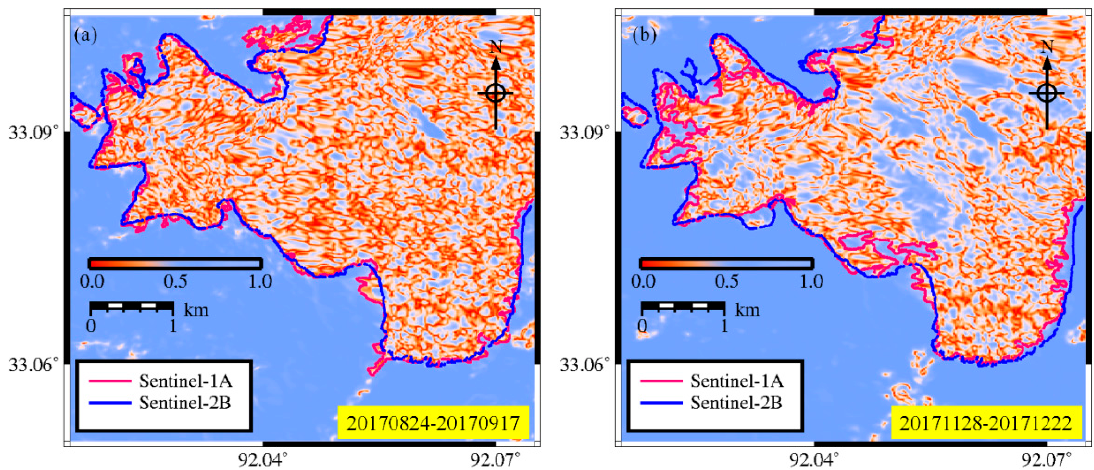
Figure 12. ( a , b ) show the two maps of DDG boundaries (solid red curves) extracted using the Sentinel-1A coherence maps around September and December in 2017, respectively. The DDG boundaries (solid blue curves) derived from the Sentinel-2B optical image are superimposed for a visual check.